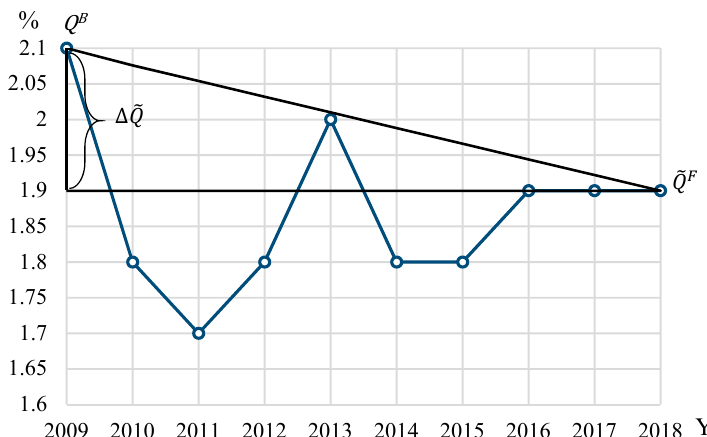
Figure 4. Energy development in the Belgian agricultural sector over the 2009–2018 period (source: compiled by the authors).